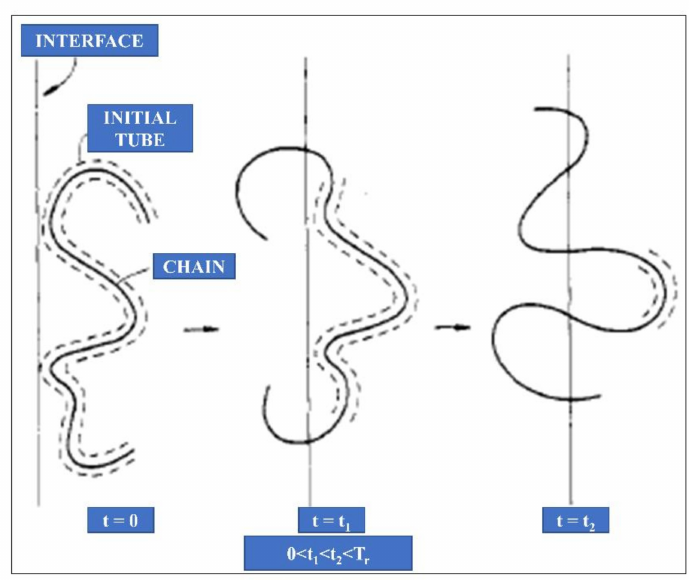
Figure 10. Polymer chain disentanglement from its initial tube near the interface [161]. Copyright (1981) American Chemical